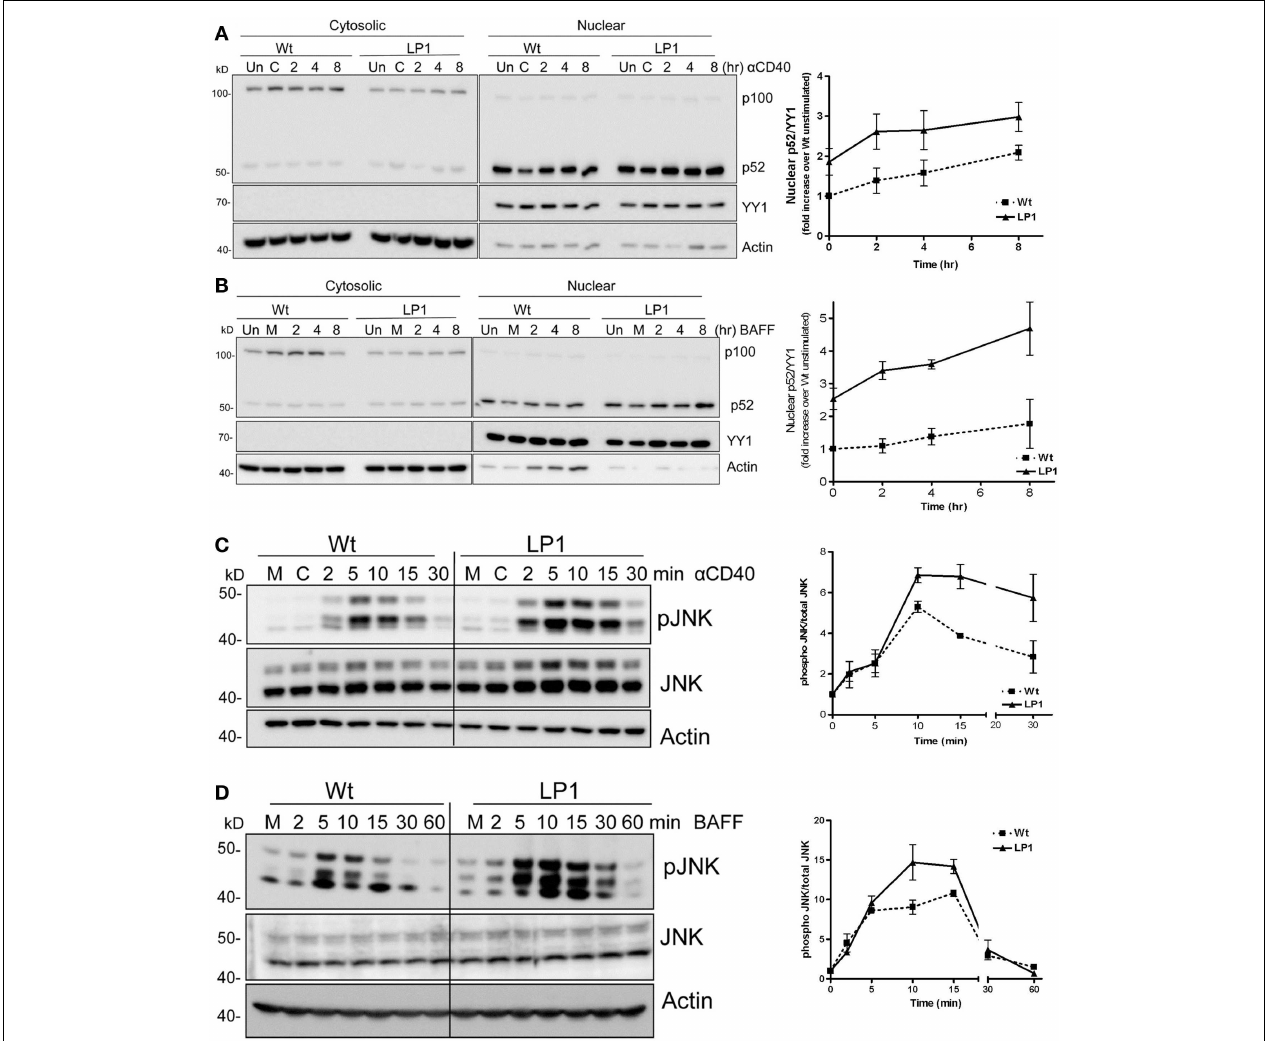
from cells stimulated via CD40 (A) or BAFFR (B) are shown. Graphs in (A,B) show mean values ± SEM of fold increases in normalized